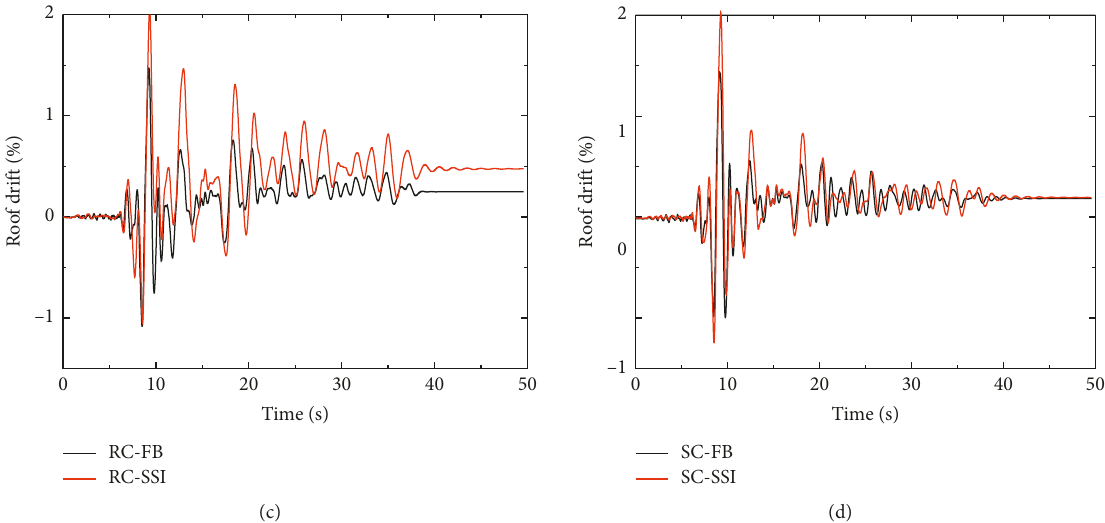
Figure 6: Roof drift-time histories under the LP89slc record scaled to DBE and MCE. (a) RC frames (DBE). (b) SC frames (DBE). (c) RC frames (MCE). (d) SC frames (MCE).